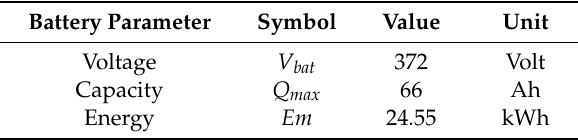
Table 3. Battery energy capacity